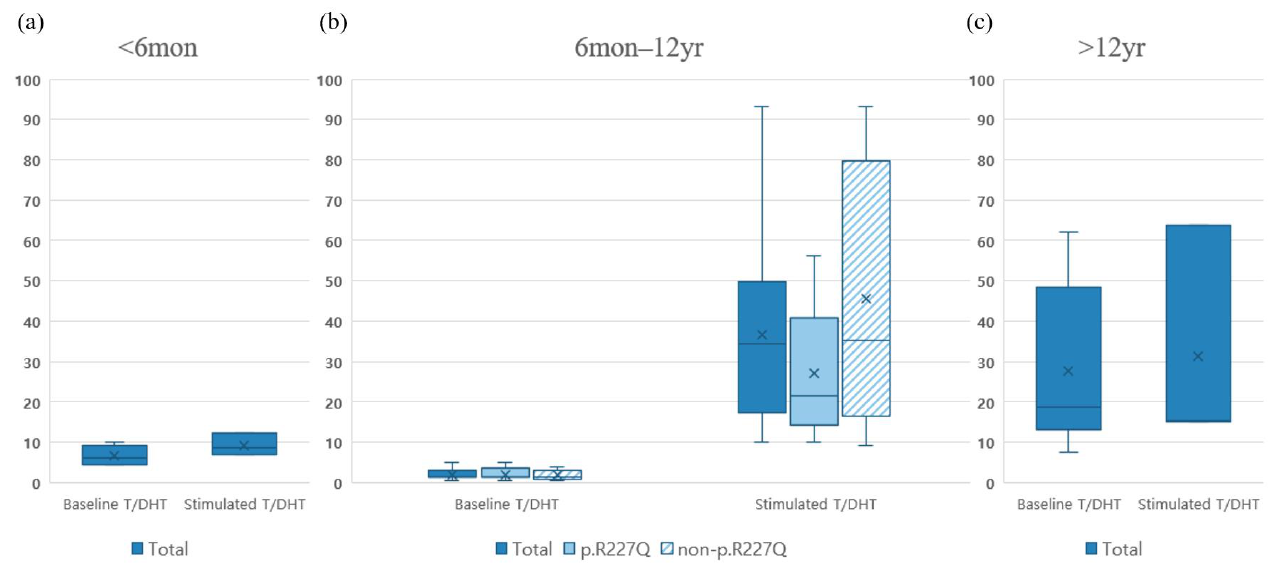
Figure 3. Median T/DHT ratios at baseline and after hCG stimulation, grouped according to age and with or without the p.R227Q allele. ( a ) <6 months old (N = 4 at baseline and N = 3 after stimulation, all patients were in the non-p.R227Q variant allele group). ( b ) 6 months – 12 years old (N = 12 at baseline [N = 7, p.R227Q; N = 5, non-p.R227Q] and N = 13 after stimulation [N = 8, p.R227Q; N = 5, non-p.R227Q]). ( c ) >12 years old (N = 11 at baseline and N = 3 after stimulation, only two participants were in the non-p.R227Q variant group). × and horizontal line represented the mean and median values, respectively.